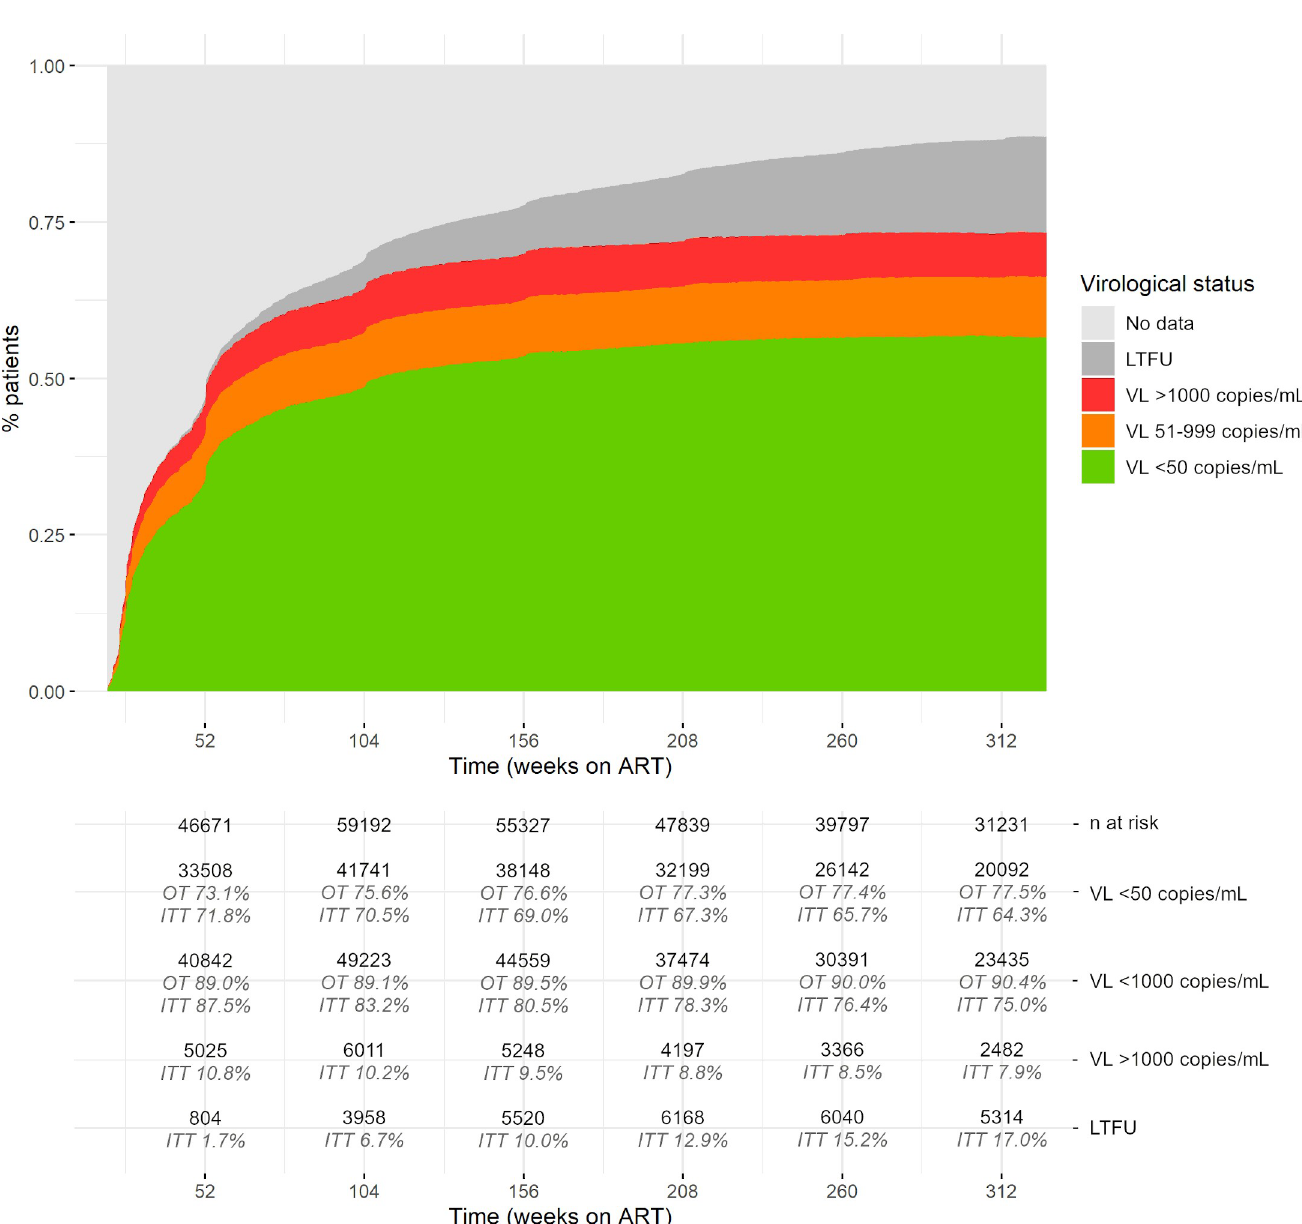
Fig 2. Multistate model of virological suppression during follow-up on first-line ART. Note: Multistate models of 104,719 patients on first-line ART. ART, antiretroviral treatment; ITT, intention-to-treat; LTFU, loss to follow-up; OT, on-treatment; VL, viral load.